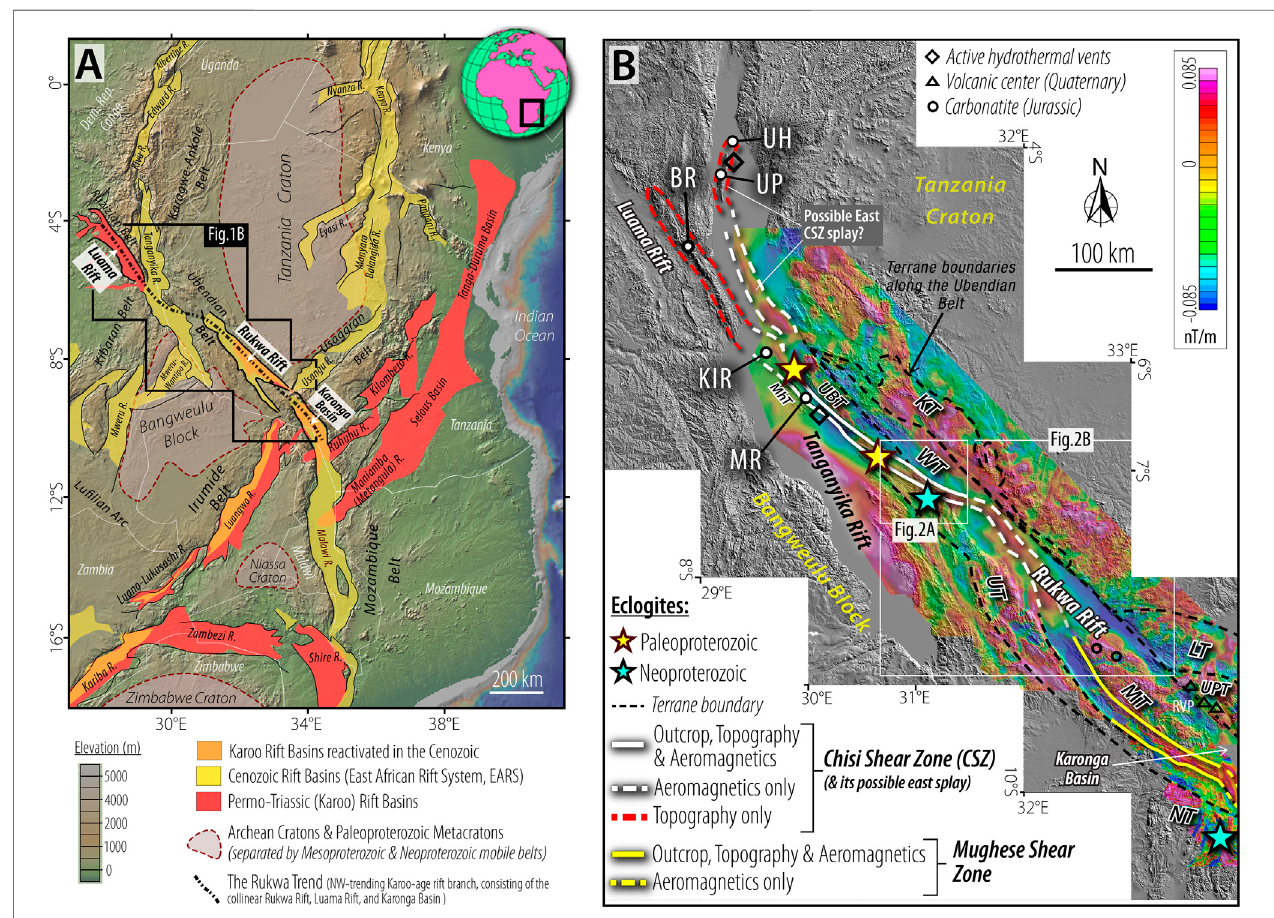
FIGURE 1 | (A) : Map of East Africa showing the Permo-Triassic (i.e., Karoo rift system) rift segments, and the currently active rift segments (i.e., East African Rift System). (B) : Shuttle Radar Topography Mission (SRTM) Digital Elevation Model (DEM) hillshade map covering the Rukwa Rift Trend, overlaid with the vertical derivative aeromagnetic of SW Tanzania. Black dashed lines represent boundaries of the Precambrian terranes of the Rukwa Rift Trend (after Daly, 1988; Lenoir et al., 1994; Delvaux et al., 2012; Lemna et al., 2019; Heilman et al., 2019). Locations ofProterozoic eclogites in the Ubendian Belt are from Boniface et al. (2012) and Boniface andSchenk(2012).LocationsofhydrothermalventsandMesozoic-Cenozoicigneouscenters(volcanicsandcarbonatites)areobtainedfromHodgsonetal.(2017).See uninterpreted aeromagnetic and hillshade maps in Supplementary Figures 1 , 2 . Geomorphic features: BR (Busindi Ridge), KIR (Kavala Island Ridge), MR (Mahale Ridge), UP (Ubwari Peninsula), UH (Ubwari Horst). Terranes of the Ubendian Belt: KT (Katuma Terrane), LT (Lupa Terrane), MT (Mbozi Terrane), MhT (Mahale Terrane), RVP (Rungwe Volcanic Province), UBT (Ubende Terrane), UPT (Upangwa Terrane), UT (U fi pa Terrane), WT (Wakole Terrane).